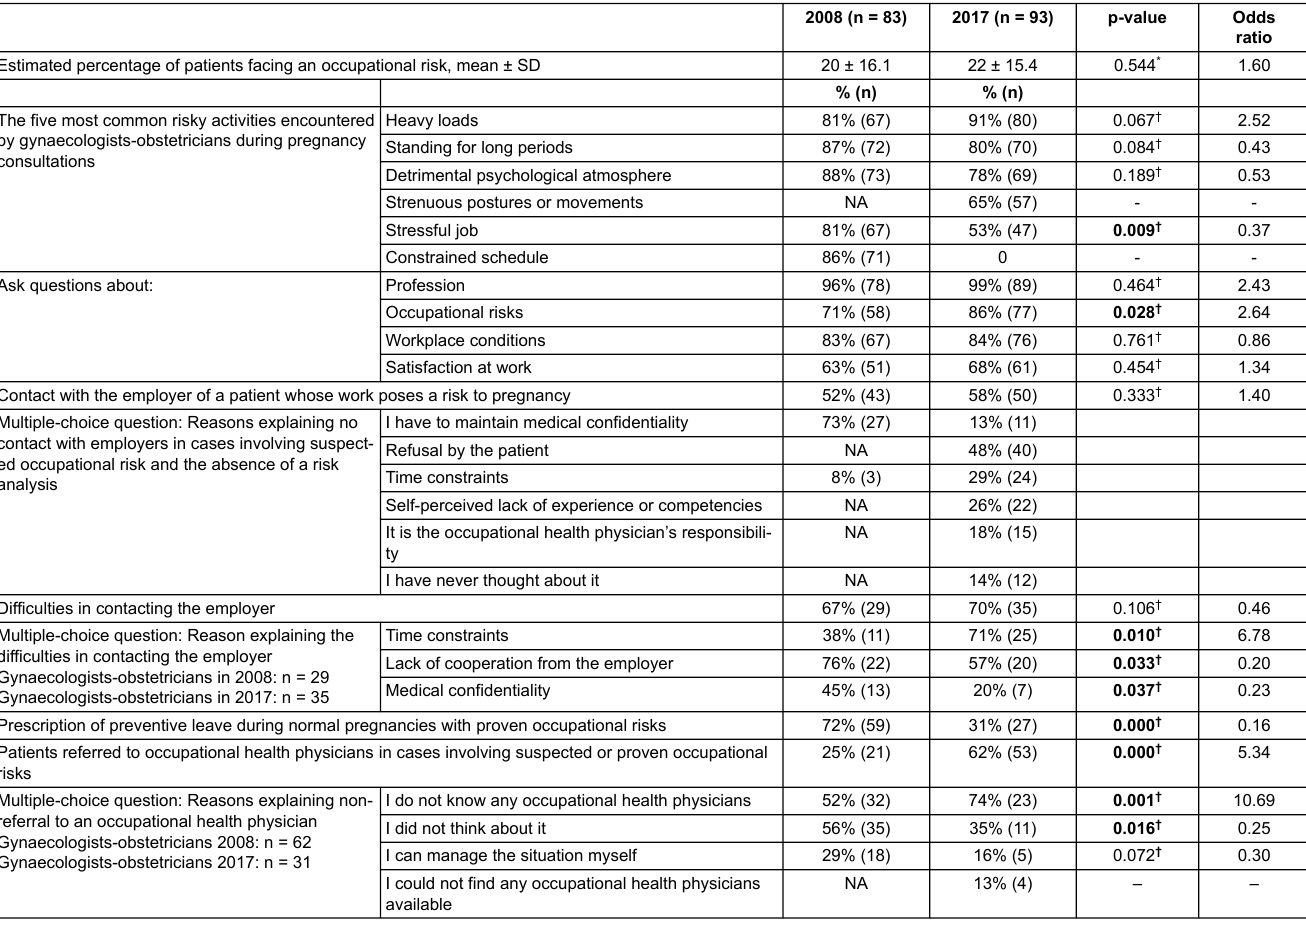
Table 6: Comparison of gynaecologists-obstetricians’ responses in the 2008 and 2017 surveys.